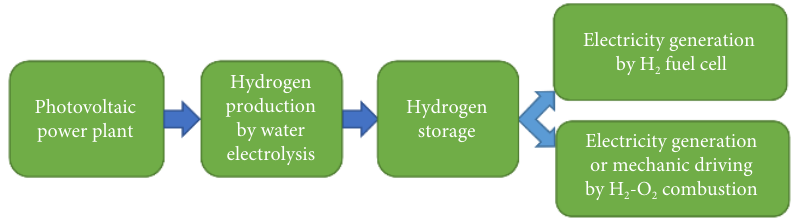
Fig. 1 The technical route of hydrogen energy